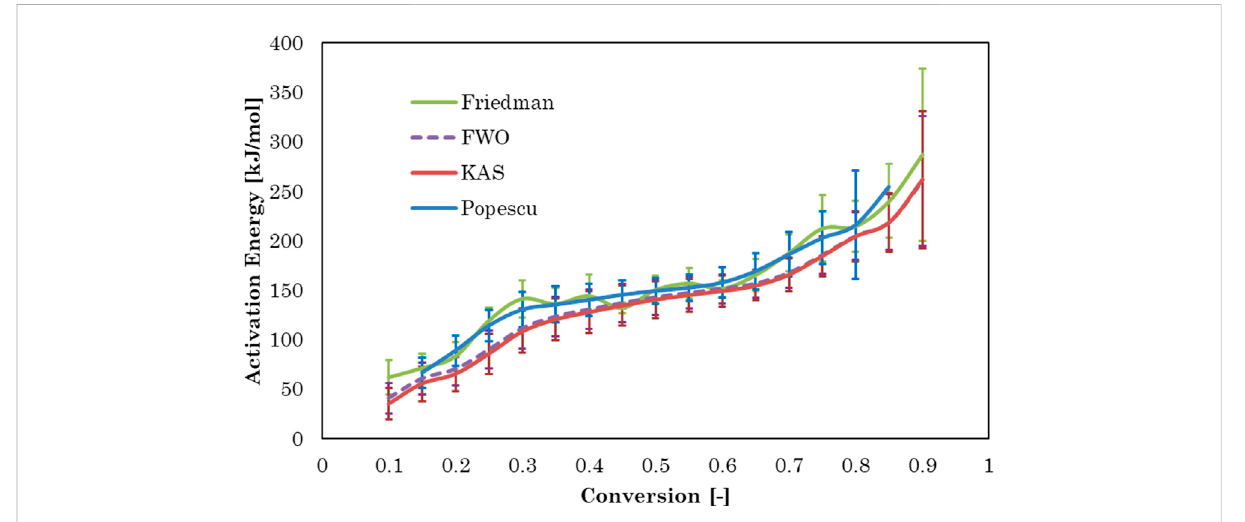
FIGURE 7 Activation energy versus conversion for four model-free methods.